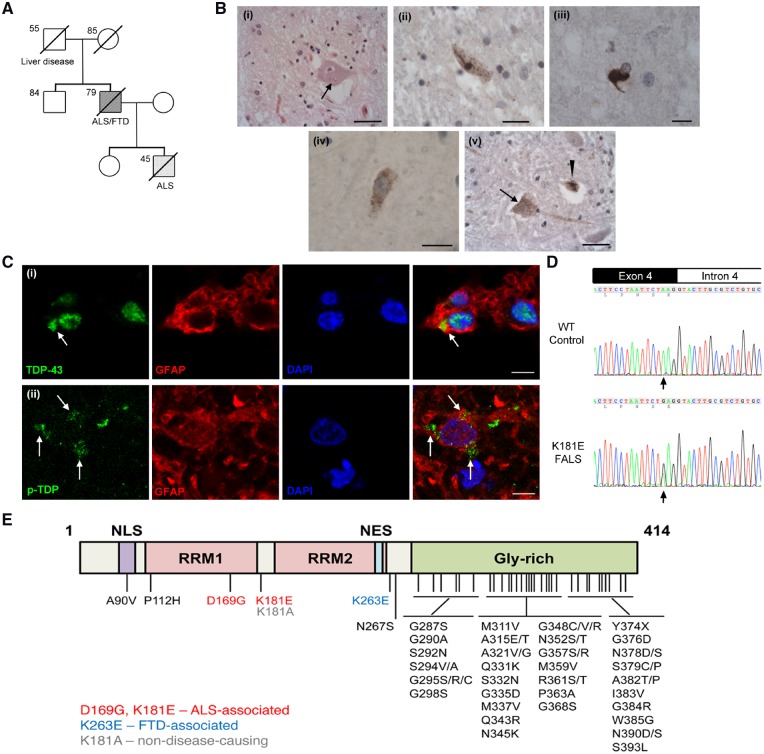

Identification of the K181E mutation in a family of ALS/FTD. (A) The pedigree of the ALS/FTD kindred carrying the K181E mutation is shown. Affected individuals are indicated by shaded symbols, deceased individuals with a slash, and numbers indicate current age or age at death. (B) Brain and spinal cord pathology of index patient. [B(i)] Bunina bodies (arrow) observed in a slightly atrophic anterior horn neuron from the spinal cord. [B(ii)] Granular/skein-like pTDP-43-positive cytoplasmic inclusion in an atrophic anterior horn neuron from the spinal cord. [B(iii)] A pTDP-43-positive glial cytoplasmic inclusion within the spinal cord. [B(iv)] A motor neuron from the motor cortex containing granular cytoplasmic pTDP-43-positive inclusions. [B(v)] The XIIth nerve nucleus of the medulla showing skein-like (arrowhead) and granular (black arrow) cytoplasmic pTDP-43-positive neuronal inclusions. Scale bar = 50 µm in i, ii, iv, v; 20 µm in iii. (C) Cytoplasmic TDP-43 [C(i), arrow] and p-TDP-43-positive inclusions [C(ii), arrows] observed in GFAP-positive cells. Images were taken in the area of anterior horn from the spinal cord. Scale bar = 5 µm. (D) Sanger sequencing chromatogram demonstrating a wild-type control and a heterozygous single base substitution (c.541A>G) predicted to substitute lysine for glutamic acid (p.Lys181Glu, K181E) in the index patient and his father. (E) Schematic overview of TDP-43 protein domain structure and disease-associated mutations.